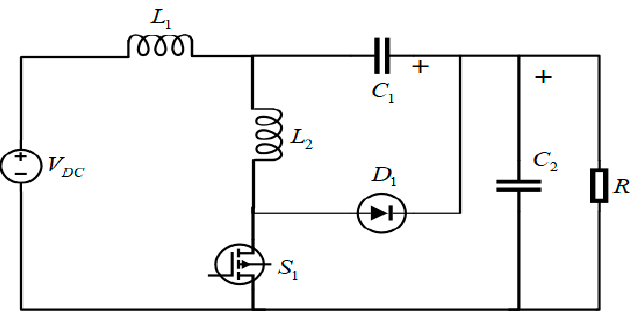
Figure 11. Circuit diagram of one of the converters considered in this study (E1).